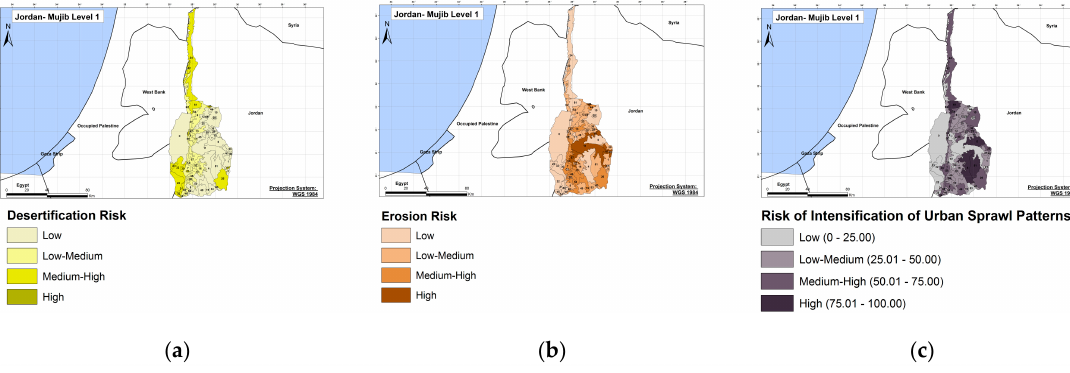
Figure 11. Hazard Maps for LDU’s of Desertification (left), Erosion (middle), and Intensification of urban sprawl (right) in Jordan: Al-Yarmuk ( a – c ) and Mujib ( d – f ).